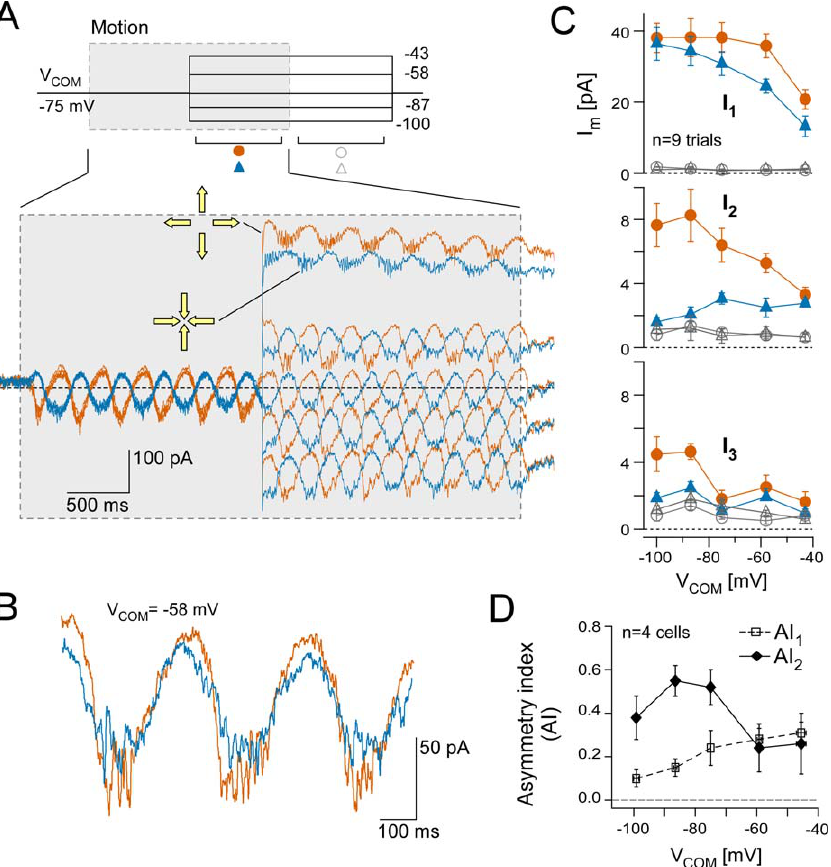
Figure 5. Voltage Dependence (A) Whole-cell voltage-clamp current responses evoked by circular wave stimuli (3 Hz; 46% contrast; period: 192 l m; averages of three trials; Cs þ -based intracellular solution) while the somatic potential ( V COM ) was stepped from (cid:2) 75 mV to the potentials indicated. Stimulation sequence was repeated for different step potentials after waiting for 2 s. Gray area indicates motion duration. (B) Traces for CF motion (orange) and CP motion (blue) from (A) (for the voltage step to (cid:2) 58 mV) magnified and aligned (shifted by 167 ms) to illustrate difference in waveforms. (C) Amplitudes of the fundamental ( I 1 ) , and the second and third harmonics ( I 2 , and I 3 ) as a function of V COM (analysis as in Figure 2.; averages of nine trials; same cell as in [A] and [B]). Motion (orange/blue-filled symbols) and no-motion (gray open symbols) data, both during voltage steps, are plotted. (D) AI s for V 1 (open squares) and V 2 (filled diamonds) as functions of V COM . doi:10.1371/journal.pbio.0050185.g005 PLoS Biology |